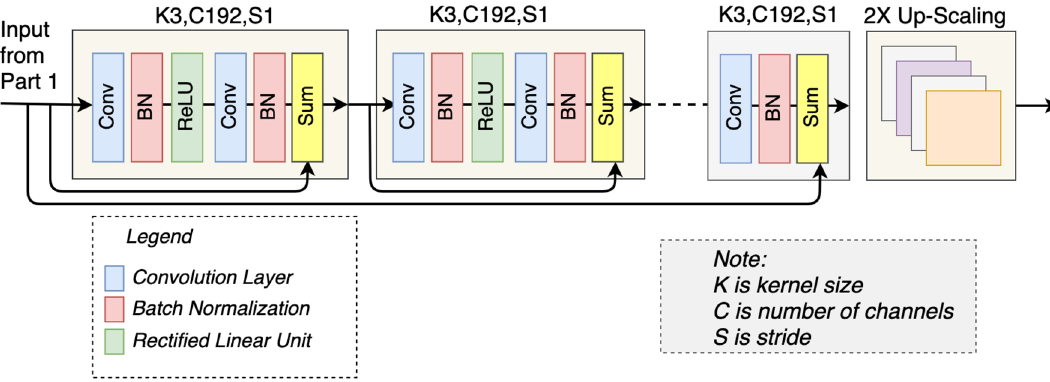
Figure 3. Proposed architecture for the deep features extraction and 2x-upscaling. The dotted line represents 17 blocks, comprising the layers shown in first two blocks. K, C and S represent kernel size, number of Channel and Stride respectively. After this step, we get features map of 2x-upscaled high resolution (HR)